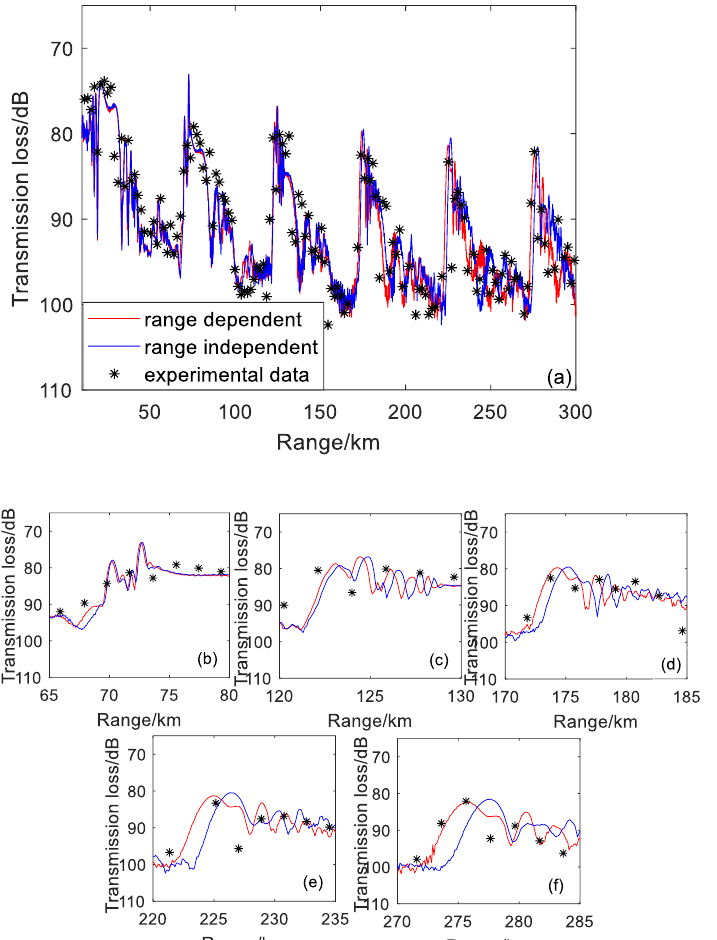
Figure 13. Transmission loss obtained from experiment and simulation. Results from ( a ) complete path and from ( b – f ) first to fifth convergence zones. In each graph, red line is the result of range dependent case. Blue line is the result of range independent case. The asterisk is the result of experimental data.